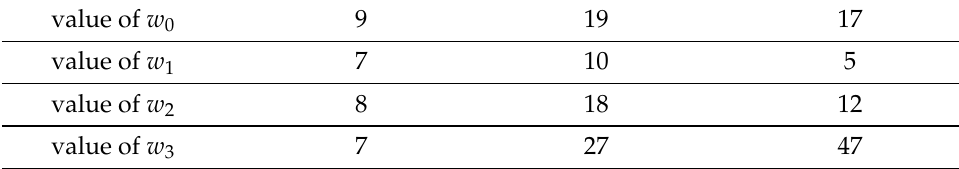
Table 2. Different values of weights for open and closed rational